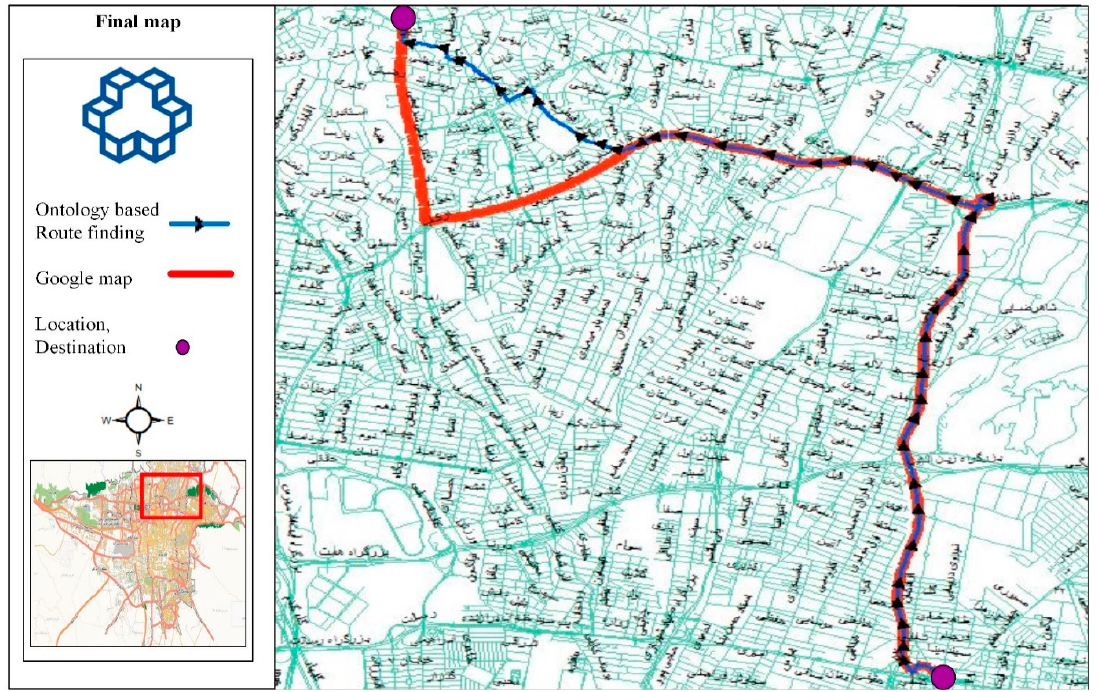
Figure 11. Comparison of two methods at peak traffic times.